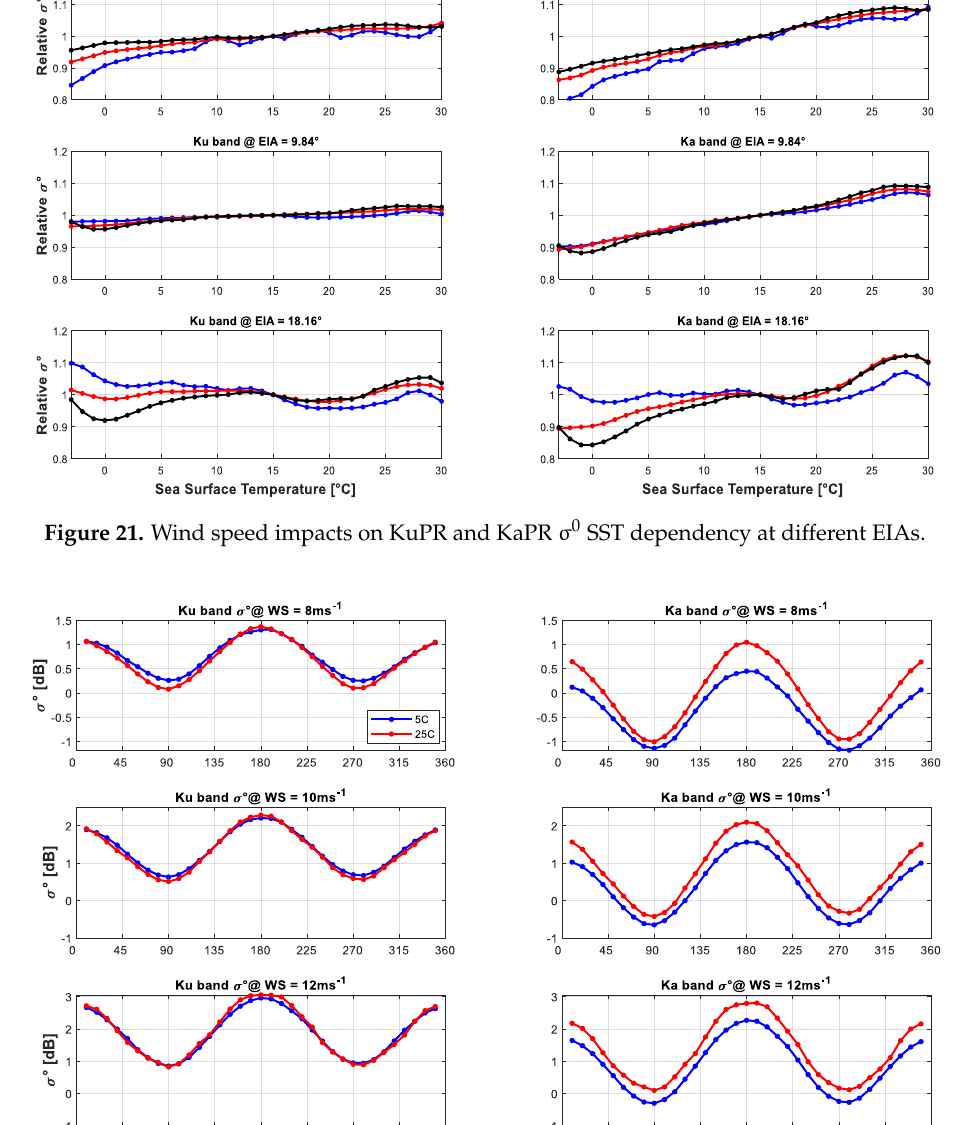
Figure 21. Wind speed impacts on KuPR and KaPR σ 0 SST dependency at different EIAs.